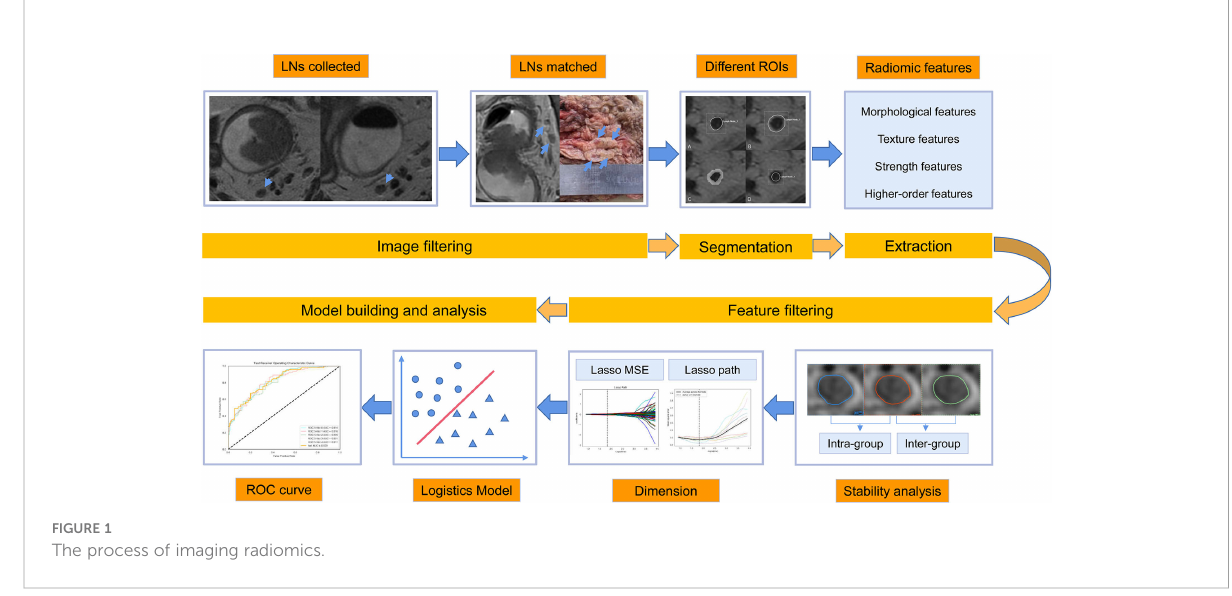
FIGURE 1 The process of imaging radiomics.